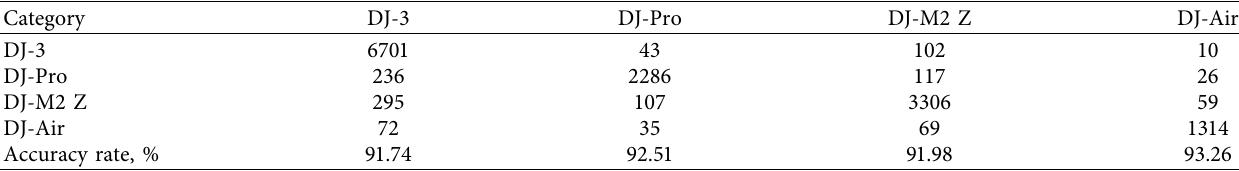
Table 3: Confusion matrix of improved YOLOv3 classification results.